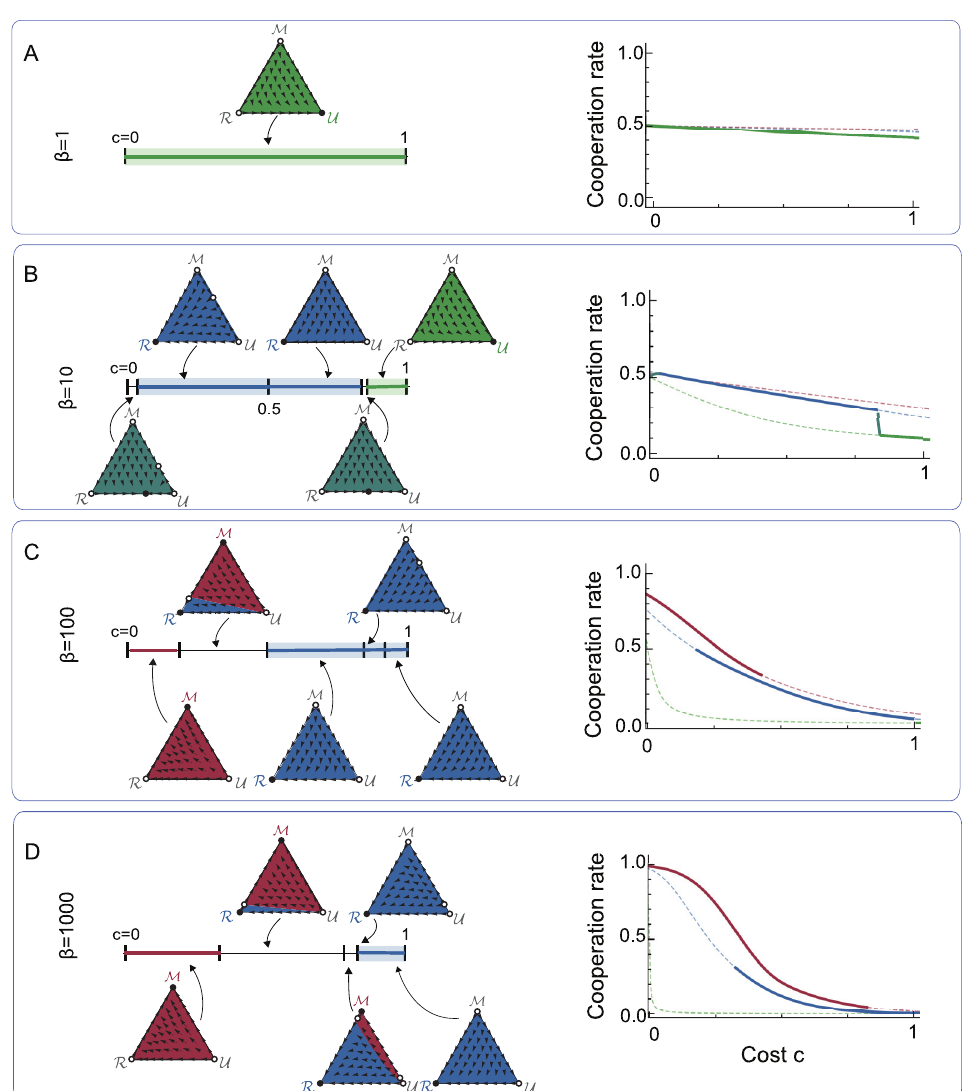
Fig 4. A bifurcation analysis of the evolutionary dynamics of memory spaces. We explore the replicator dynamics of the three different memory spaces for four different selection strengths β . In each case, we first classify the dynamics as we vary the cooperation cost from c = 0 to c = 1 (left graphs). Here, triangles show representative depictions of the dynamics. Colors indicate basins of attractions of each possible fixed point. If a given memory space S in a given cost interval, the respective line segment is appropriately colored. Colored shades around these line segments indicate a memory dilemma. Second, we also illustrate the average cooperation rate in monomorphic populations for each of the possible memory spaces (right graphs). If the respective monomorphic population is stable according to replicator dynamics, we use a solid line; otherwise we use a dashed line. a-d , For weak selection, unconditional strategies are globally stable for all cost values. As we increase selection strength, memory-1 strategies become stable when cooperation costs are sufficiently small. For large cooperation costs, reactive strategies are globally stable.